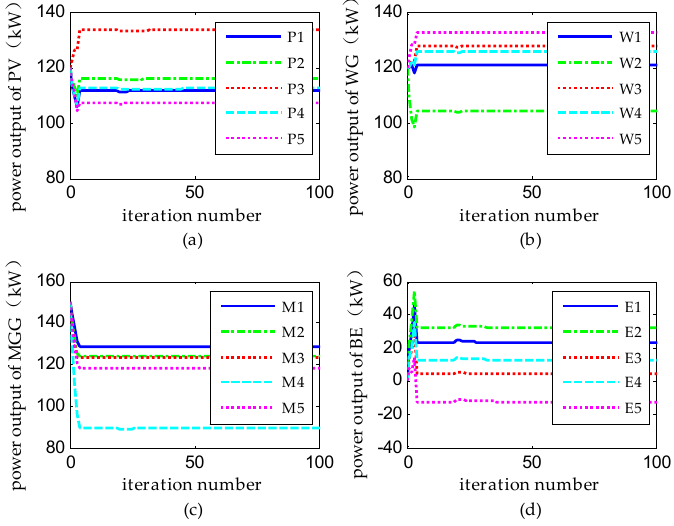
Figure 7. Dispatch results in Scenario C . ( a ) Power output of PV; ( b ) Power output of WG; ( c ) Power output of MGG; and ( d ) Power output of BE.